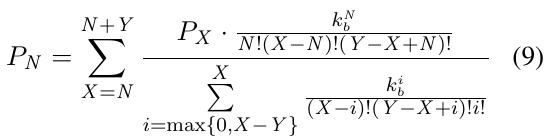
Fig. 2: Quality of approximation by the quasi-steady-state solution as function of k − /γ mined from the relation X (cid:88) P = P X X , N N =max { X − Y , 0 }